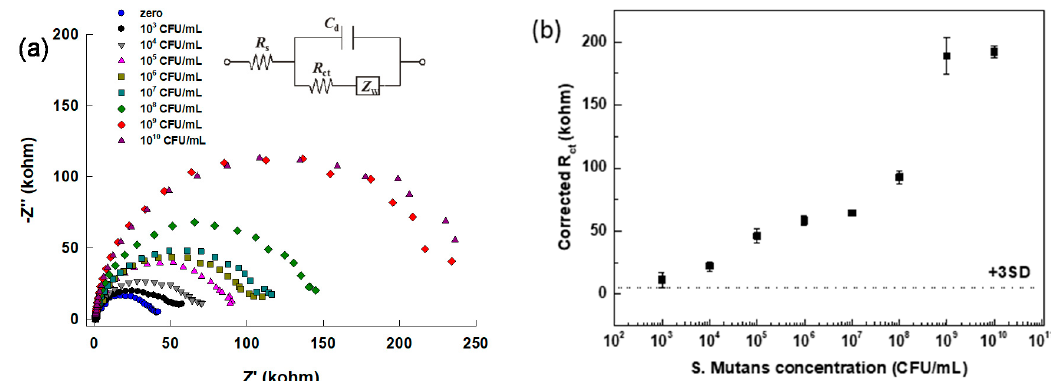
Figure 4. EIS responses of developed biosensor to detect different concentrations of S. mutans bacteria ( a ) the -Z” vs. Z’ ‘Nyquist plot’ with an inset showing the equivalent Randle’s circuit and ( b ) the extracted R ct vs. bacterial concentration calibration curve.